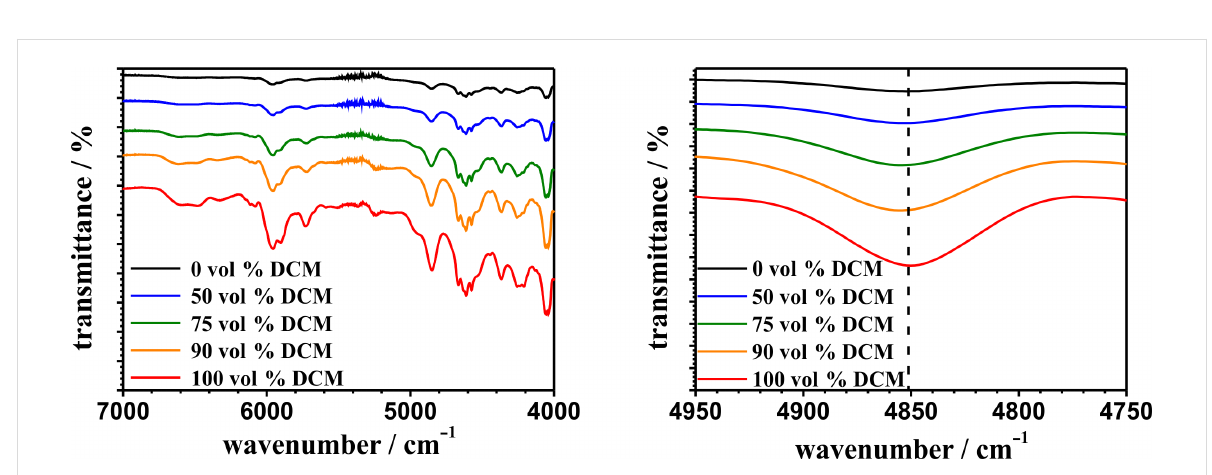
Figure 8: MIR spectra of polyphenylalanine synthesized from solution (pure THF black line and pure DCM red line) at different wavenumber regions. Dotted lines indicate typical values of the amide I vibration band for α -helix (around 1665 cm − 1 ), random coil (between 1645–1630 cm − 1 ) and β -sheet (around 1630 cm − 1 ) conformations.